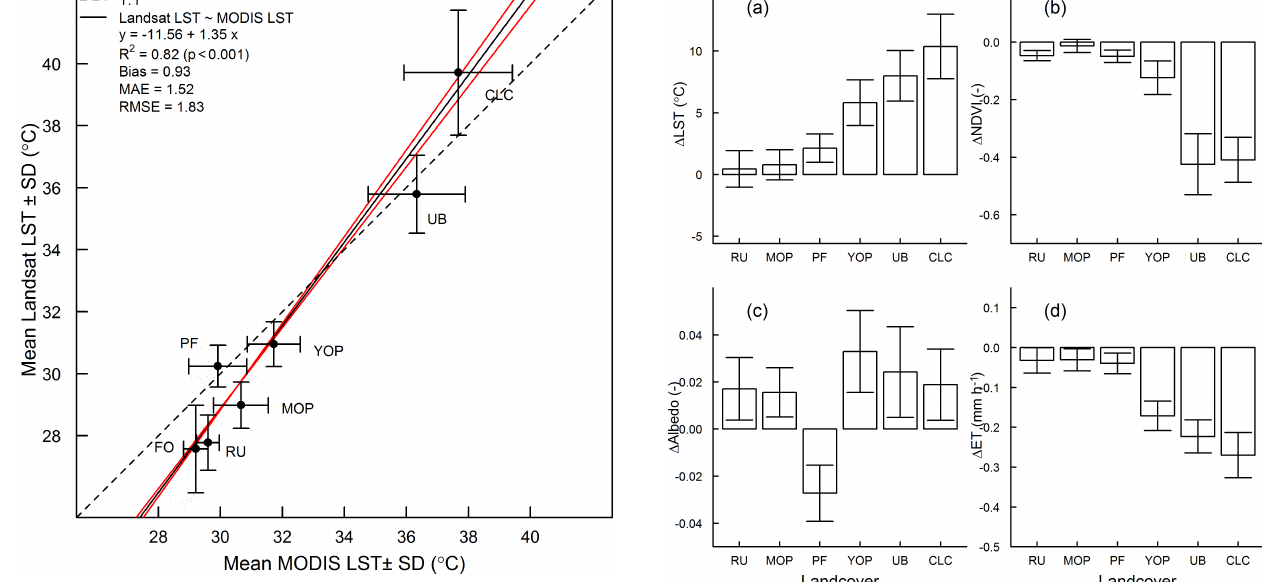
Figure 4. Differences (mean ± SD) in surface temperature ( (cid:49) LST), normalized difference vegetation index ( (cid:49) NDVI), albedo ( (cid:49) albedo) and evapotranspiration ( (cid:49) ET) between other land cov- ers (RU, MOP, PF, YOP, UB and CLC) and forest (FO) in the Jambi province, derived from a Landsat LST image acquired on 19 June 2013 at 10:13 local